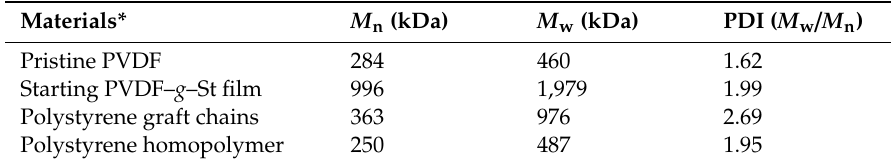
Table 1. Molecular weights of the pristine PVDF, starting PVDF– g –St, polystyrene graft chains, and the